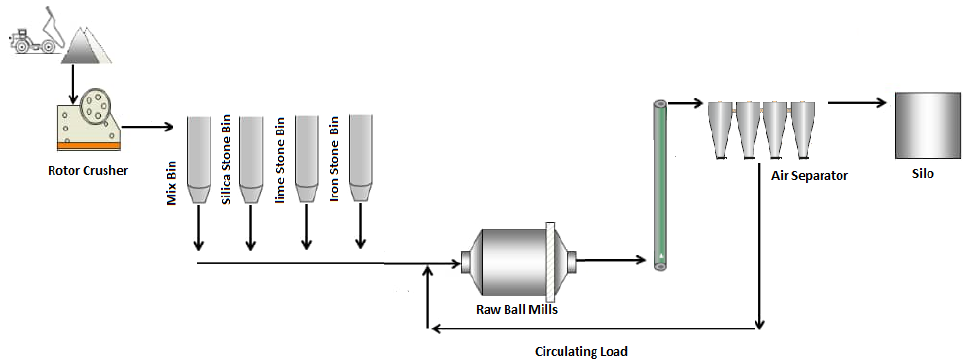
Figure 1. Schematic of ball mill circuit in the Ilam cement plant.